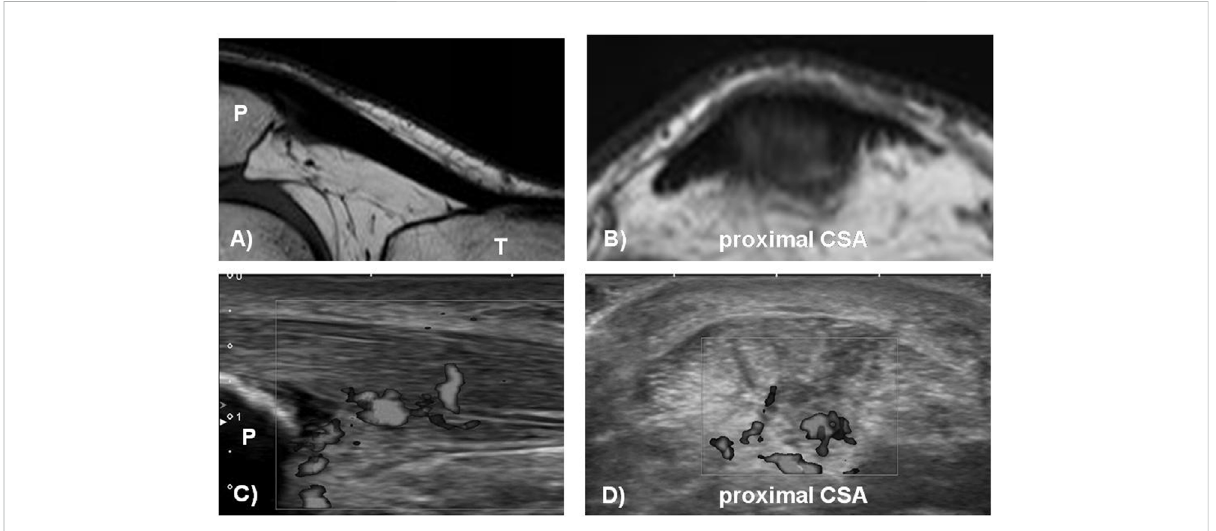
FIGURE 1 Magneticresonanceimaging[MRI, (A,B) ]andultrasound[US (C,D) ]oftendinopathicpatellartendoninthesagittalandtransversalplaneshowing tendonthickening[US (C) andMRI (A) ],hypoechoicareasandneovascularisation (C,D) andincreasedsignalintensity (B) .CSA=cross-sectionalarea; P = patella; T =